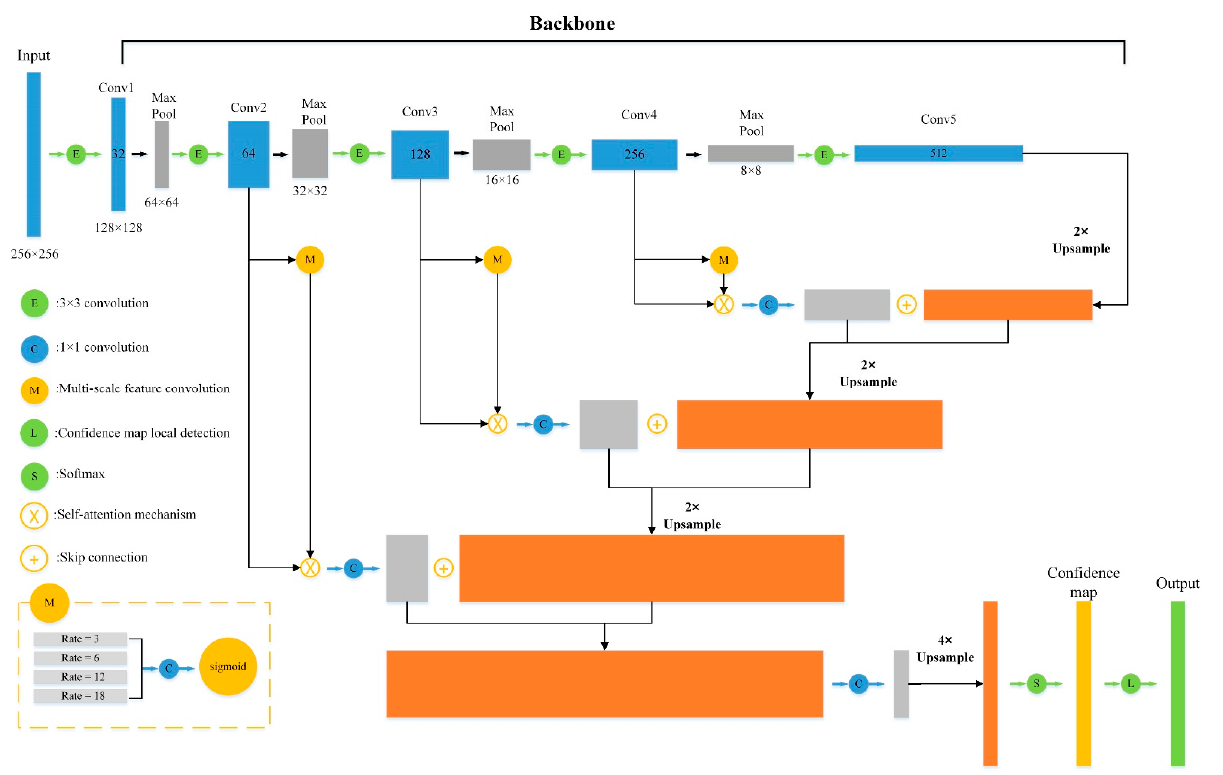
Figure 4. The architecture of the multi-scale spatial supervision convolution network. Actually, an atrous block is the aggregation of a series of dilated convolutional lay- ers combined with a 1 × 1 convolutional layer and a sigmoid layer (Figure 4). It allows us to effectively enlarge the field of view of filters without increasing the number of pa- rameters or the amount of computation and to extract spatial-pyramid-feature infor- mation [33].